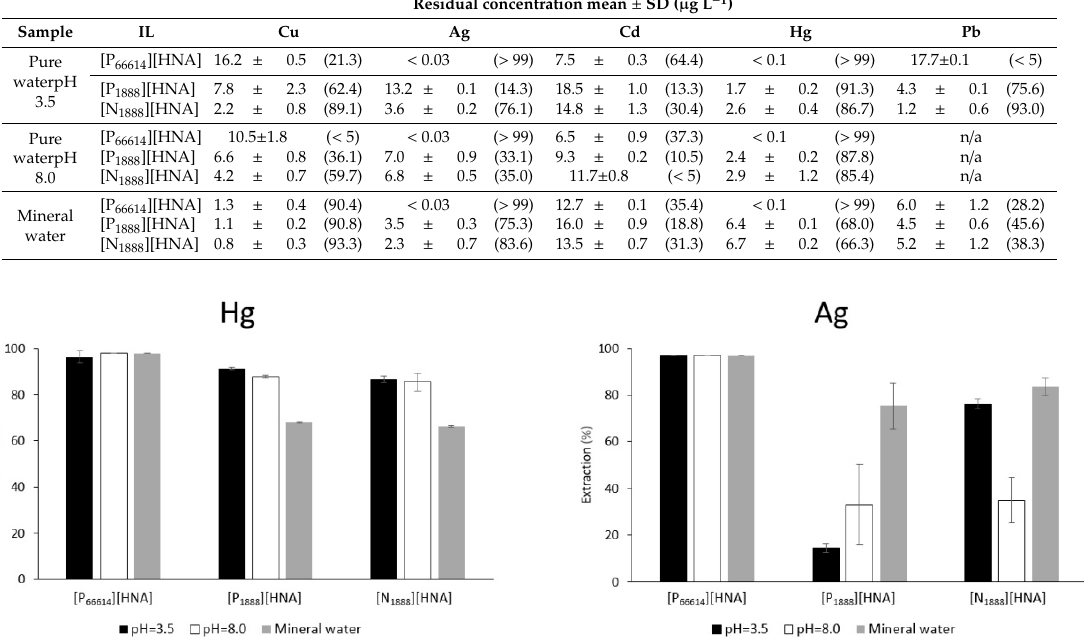
Figure 2. Extraction of 20 µ g L − 1 Hg and Ag, respectively, from pure water feed solutions at pH 3.5 and 8.0 as well as a spiked mineral water sample. Extraction time = 2 h, n = 3, error bars = ± SD.